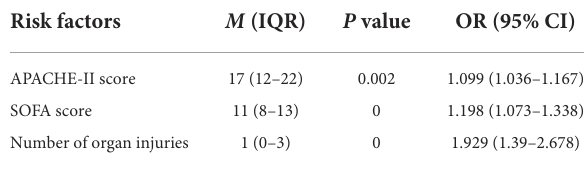
TABLE 4 Distribution of pathogens in septic shock by outcome. TABLE 5 Risk factors for septic shock